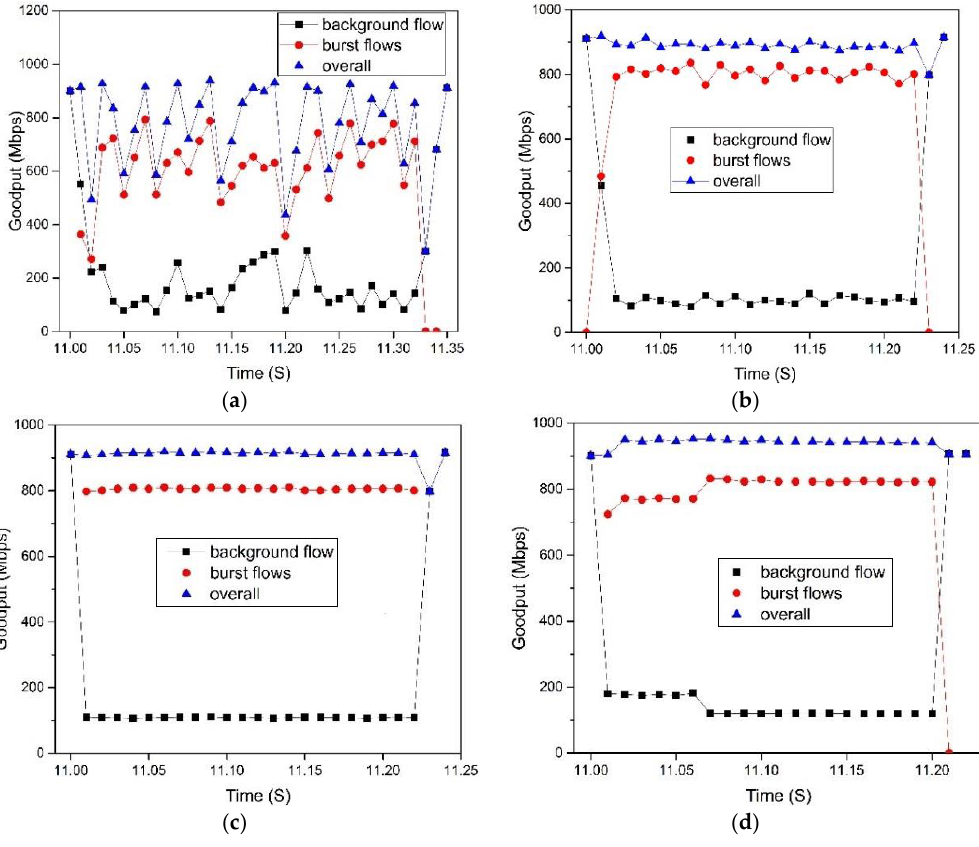
Figure 11. Goodput of background flows and burst flows with 512 KB data: ( a ) TCP; ( b ) DCTCP; ( c ) SAB; and ( d ) SDTCP.